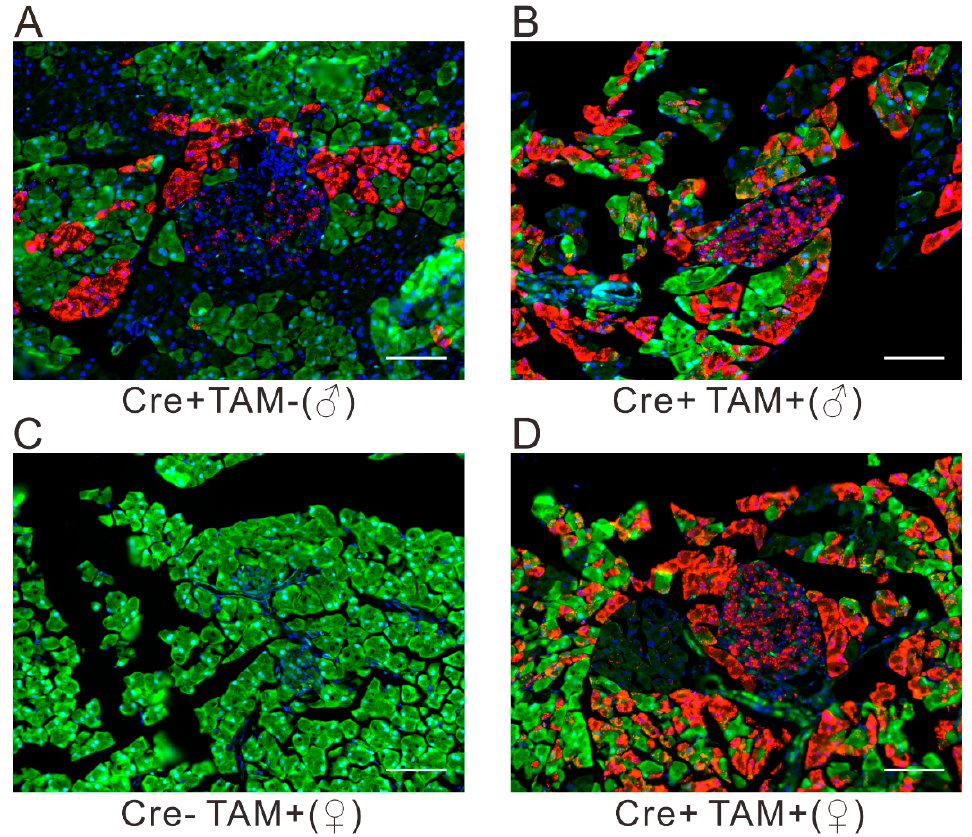
Figure 1. Cre-mediated enhanced green fluorescent protein (EGFP) and tdsRed expression in R26GRR / Pdx1-CreER TM adult mice, without ( A ) or with ( B , D ) TAM administration. The Pdx1-CreER TM ( − ) mice ( C ) or the mice without ( A ) TAM injection are shown as negative controls. Scale bar, 50 μ m.